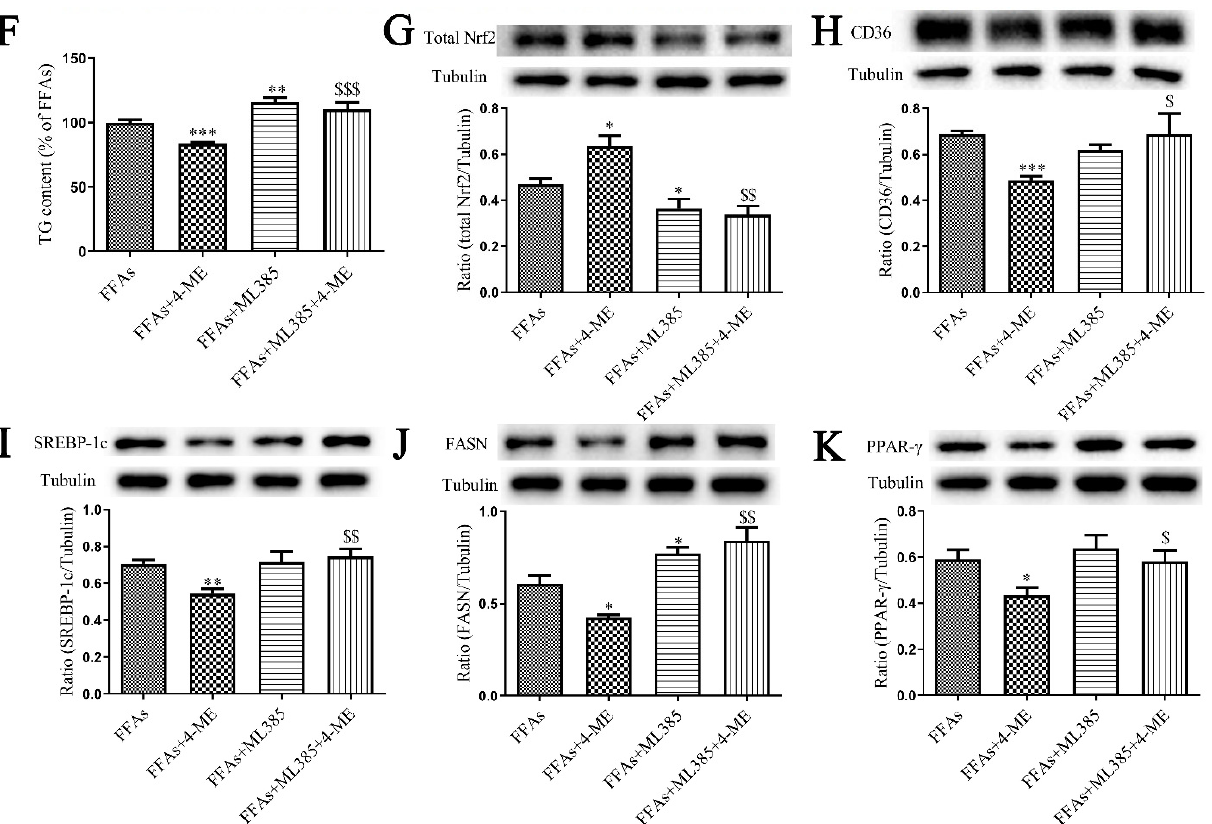
Figure 5. The 4-ME attenuated lipid metabolism by activating Nrf2. ( A – D ) The protein levels of cytosolic and nuclear Nfr2 in the liver or LO2 cells ( n = 3–4). ( E ) Oil red O staining. ( F ) Intracellular